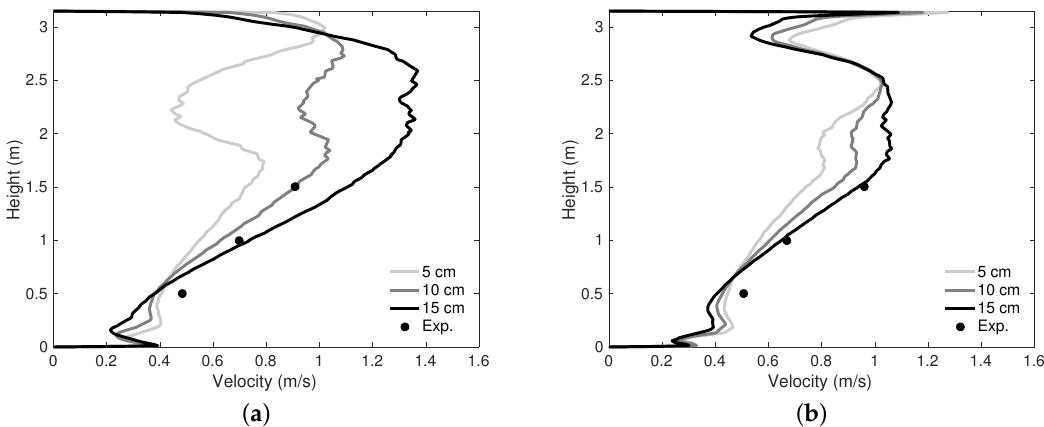
Figure 8. Velocity profiles when moving ( a ) L1 and ( b ) L2 closer to the center of the hot